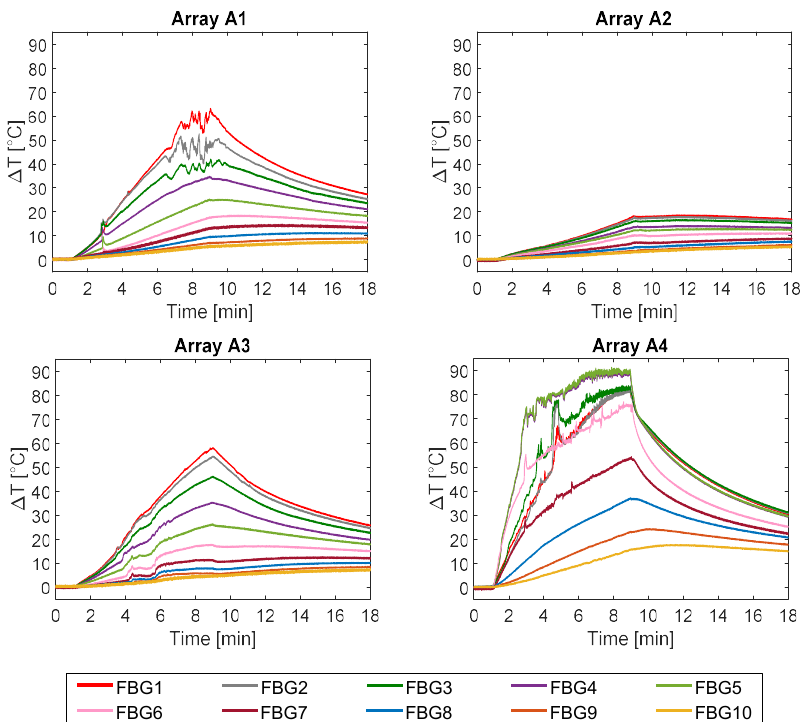
Figure 4. Temperature variations collected during the MW discharge and the cooling phase. The ten measurements recorded by the ten FBGs embedded in array A 1 and A 4 (both 5 mm far from the applicator), in array A 2 (30 mm far from the applicator), and in A 3 (15 mm far from the applicator) are shown.